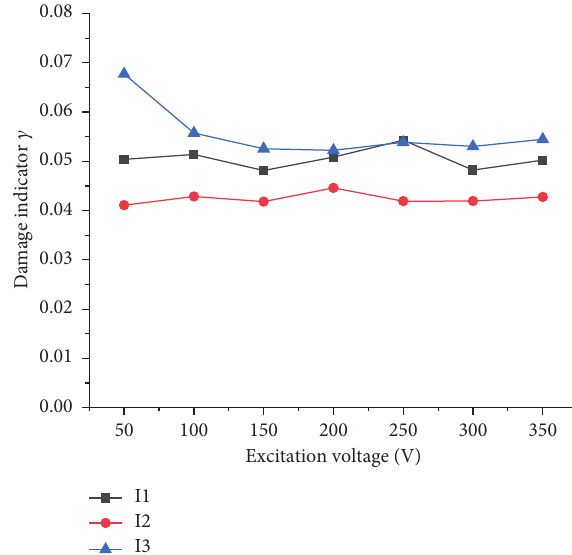
Figure 16: Distribution of the excitation voltage and the damage indicator c in specimens I1 ∼ I3.